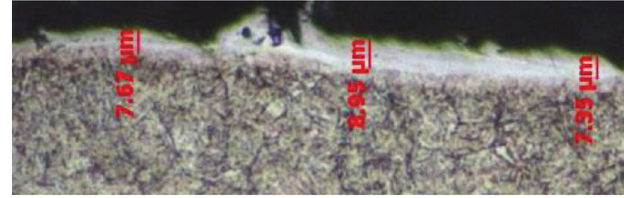
Fig. 11. White layer thickness of